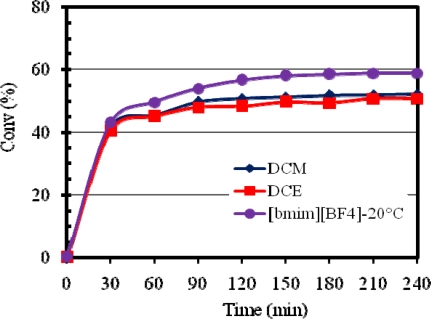
Activity of 2 in [bmim][BF4], DCM and DCE at 20 °C.